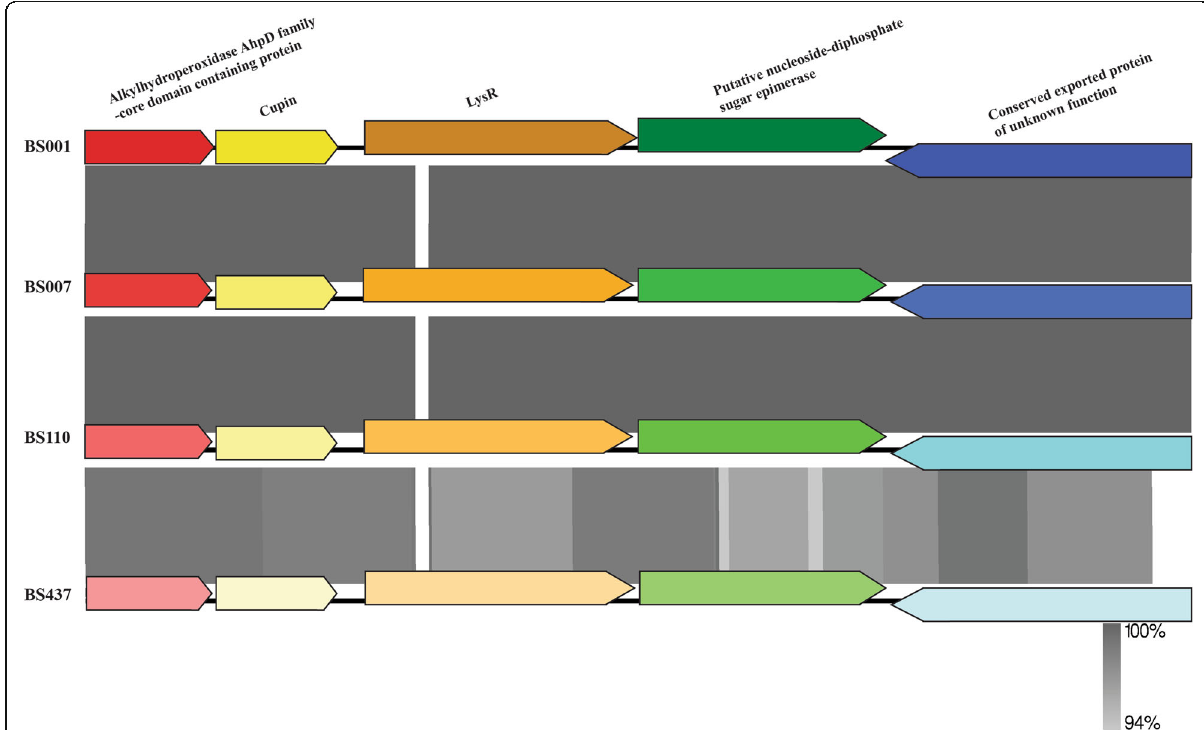
Fig. 7 Synteny comparison five-gene cluster among strains. The corresponding genes were indicated by the color boxes. Comparison percentage was generated using BLAST+ 2.4.0 (tBLASTx with cutoff value 10 − 3 ) and figures were created with the Easyfig program